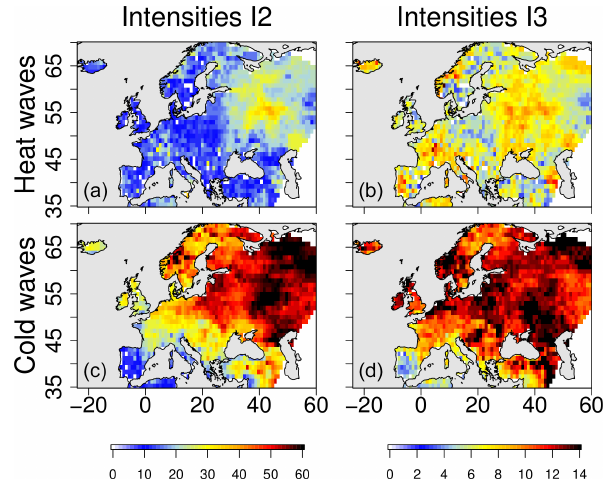
Figure 12. Intensity of the heat (a, b) and cold (c, d) waves defined with the temperature anomalies (I2, a, c ), or with constant thresh- olds (I3, b, d ) with a 10-year return period using LisFlood dataset.